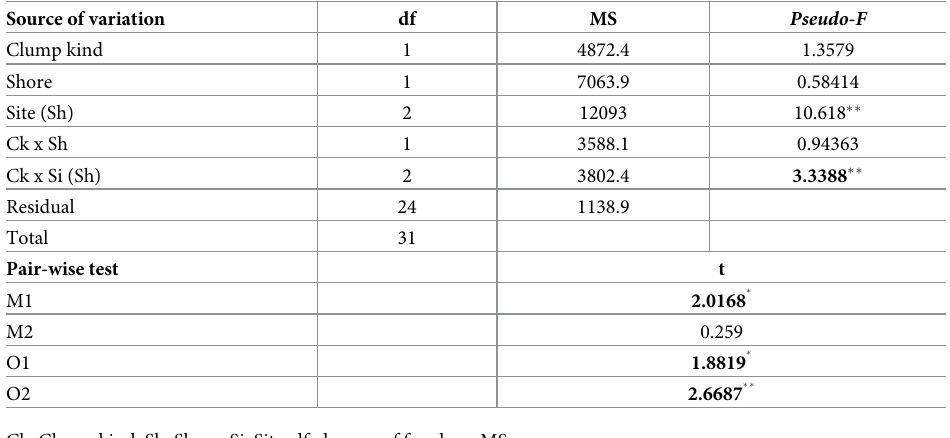
Table 3. Results of PERMANOVA testing differences in the structure of the macrobenthic assemblage between clump kinds. Analyses based on matrix of Bray-Curtis dissimilarities from untransformed data. Monte Carlo p-values were considered because the number of unique permutations was low.